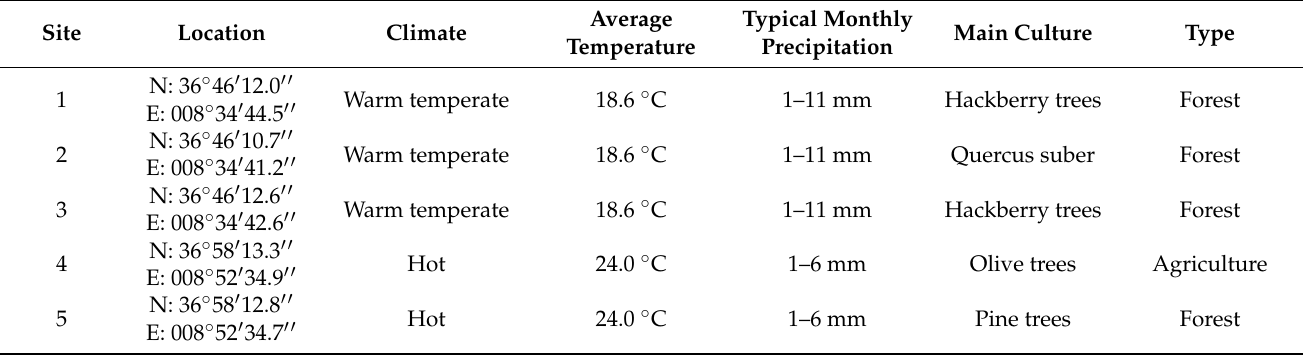
Table 1. Geographical location and characteristics of the sampling